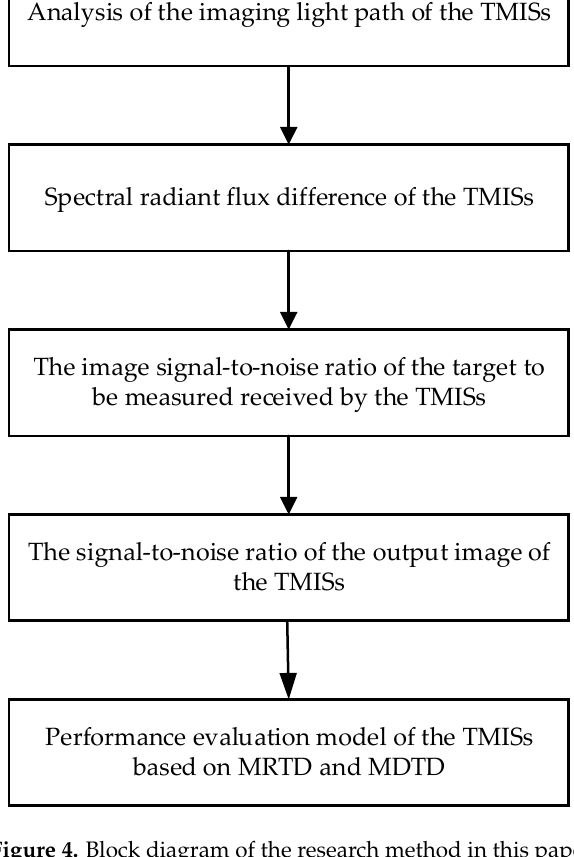
Figure 4. Block diagram of the research method in this paper.